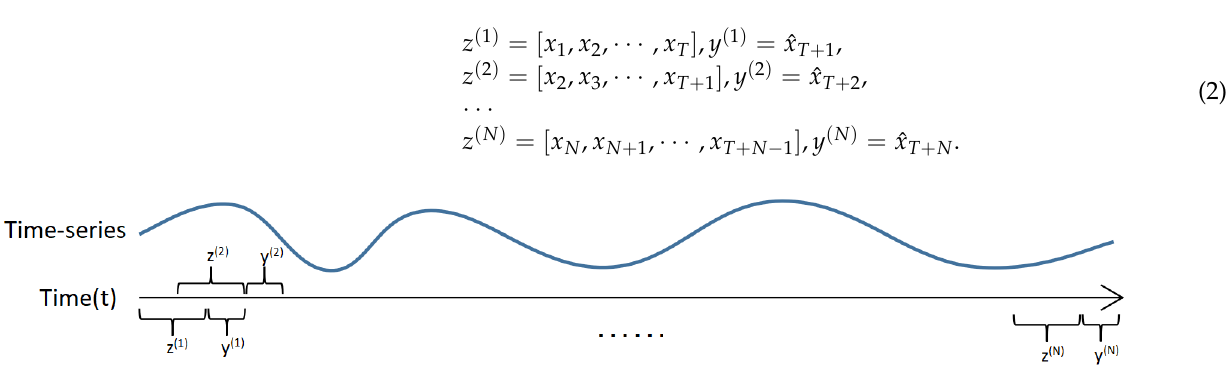
Figure 3. Schematics of the input and output data